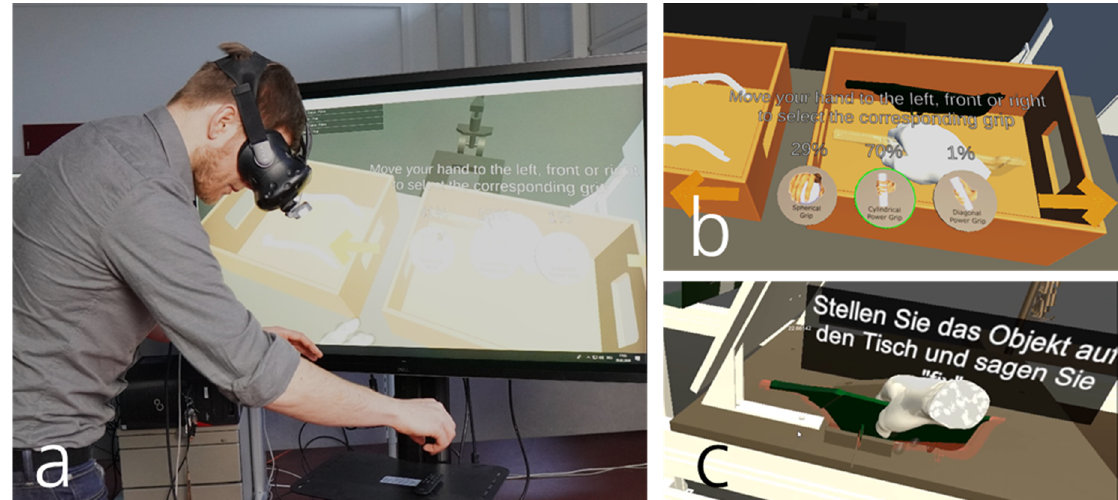
Figure 7. User interaction with the VATS ( a ) user with the head-mounted display and leap motion. He is grabbing the virtual object. ( b ) Grabbing an object and visualization of the three most likely grip types. By moving the hand to the left, front, and right it is possible to select the left, the middle, or the right grip type. ( c ) The user places the object at the final position on the assembly line.